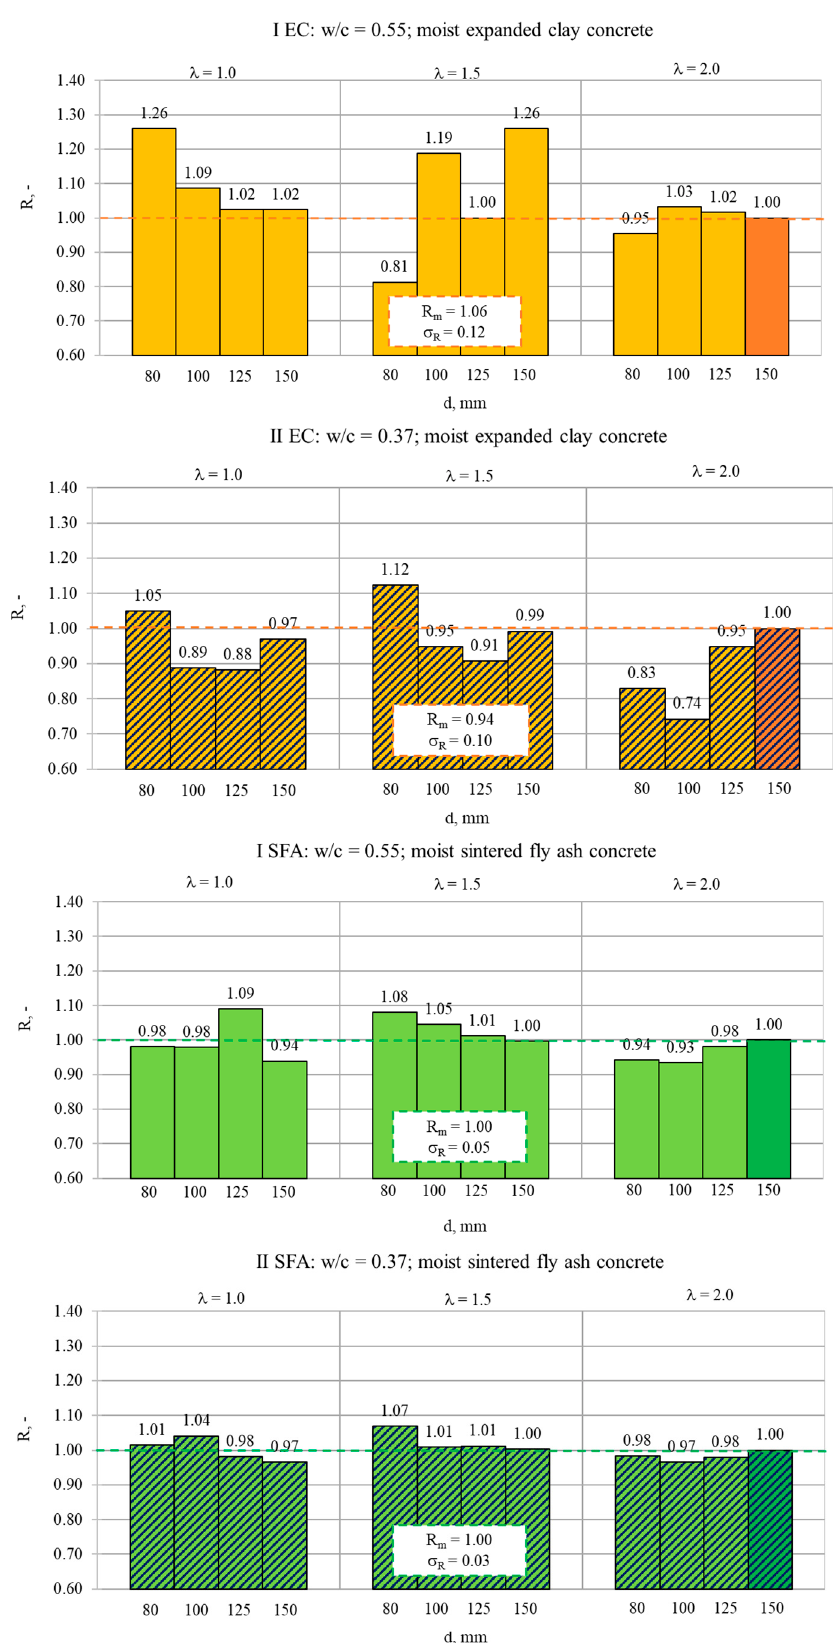
= f cm, 300:150 core